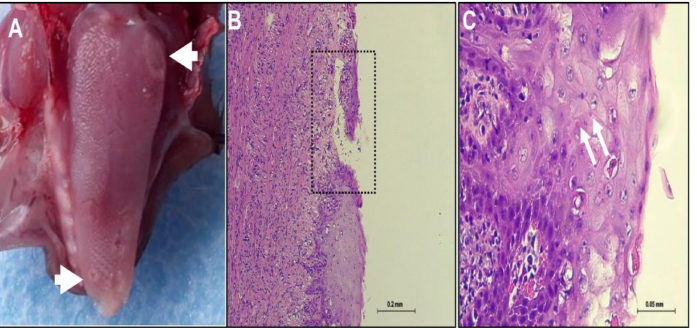
Figure 2. Development of tongue lesions caused by poxvirus disease like in suckling bats. ( A ) Plaques lesions on the tongue surface of Suckling bat no. 1375, mark by white arrows ( B ) Histology of tongue epithelia, showing ulceration (black rectangle, Magnification = 100 × ). ( C ) Intracytoplasmic eosinophilic inclusion bodies in the epithelial cells of the tongue (white arrows, Magnfication = 400 ×